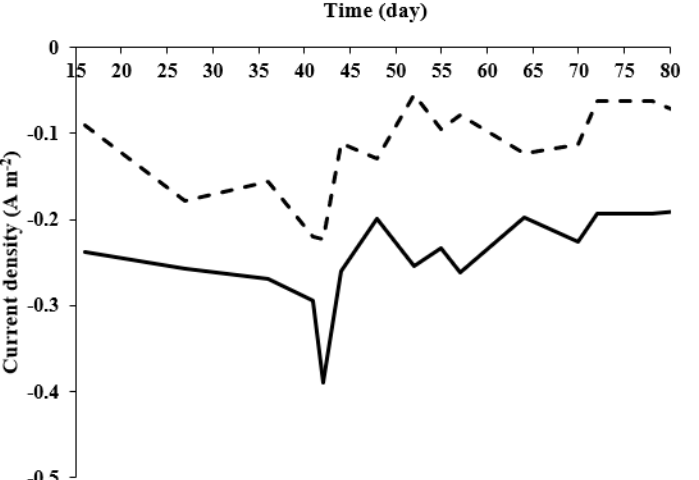
Figure 4. Reduction currents of MEC-SBP ( — ) and MEC-control ( - - - ) supplied with acetate as the sole carbon source ( A ) and artificial wastewater ( B ). The reduction currents were carried out at a scan rate of 5 mV s − 1 .